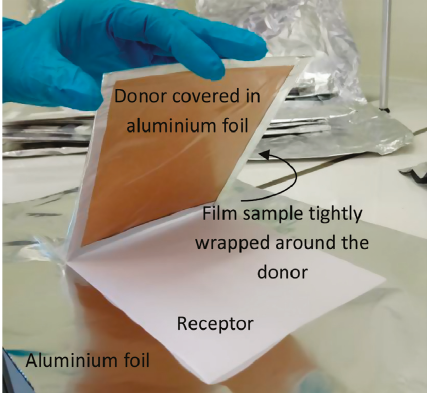
Figure 3: Test pack before being enclosed in aluminium